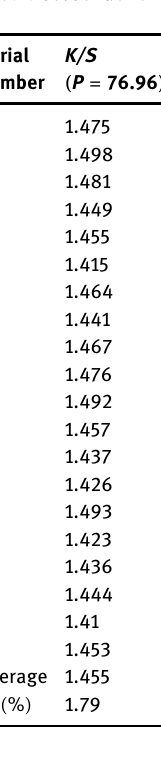
Table 2: 20 K/S data of di ff erent regions on natural indigo spun - dyed viscose